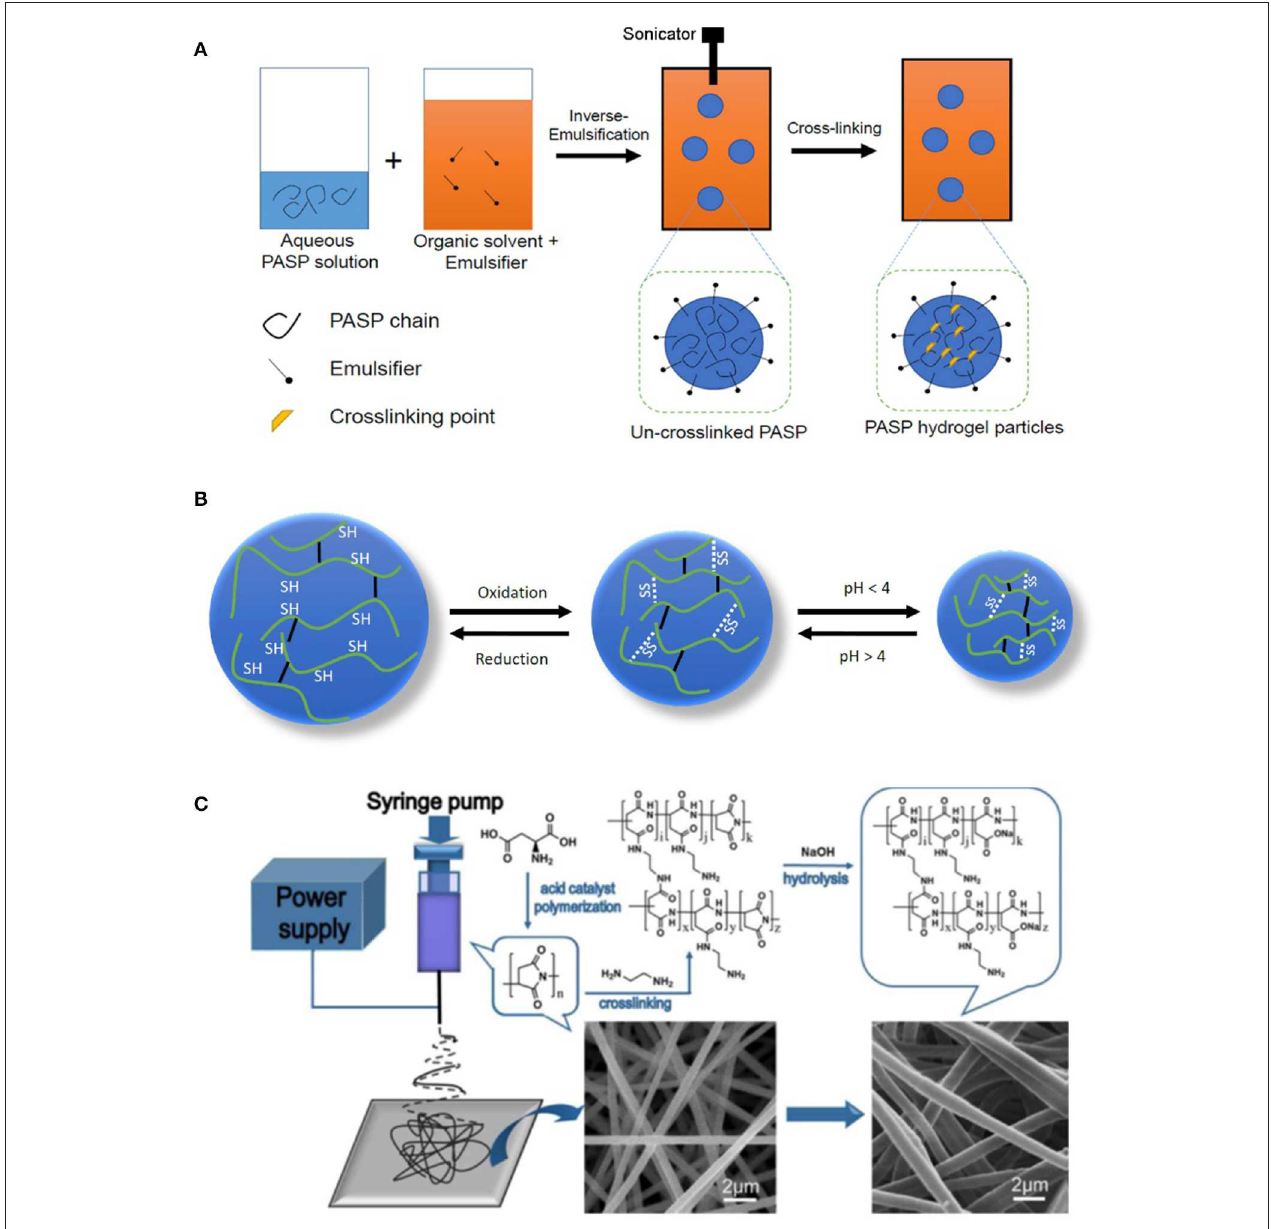
FIGURE 4 | Preparation of nanostructured PASP hydrogels. (A) Schematic representation of the preparation of PASP-based nanogels in inverse emulsion technique. (B) Schematic representing volume change of pH- and redox/reductive-responsive nanogels, white dashed lines represent cleavable disulfide bonds while solid black lines stand for permanent linker; oxidation leads to shrinkage of nanogels as crosslinking density increases, while acidic pH values protonate COOH groups of PASP, lowering the swelling. (C) Schematic representation of the method for PASP fiber hydrogel formation. Reproduced from Zhang et al. (2015) with permission from